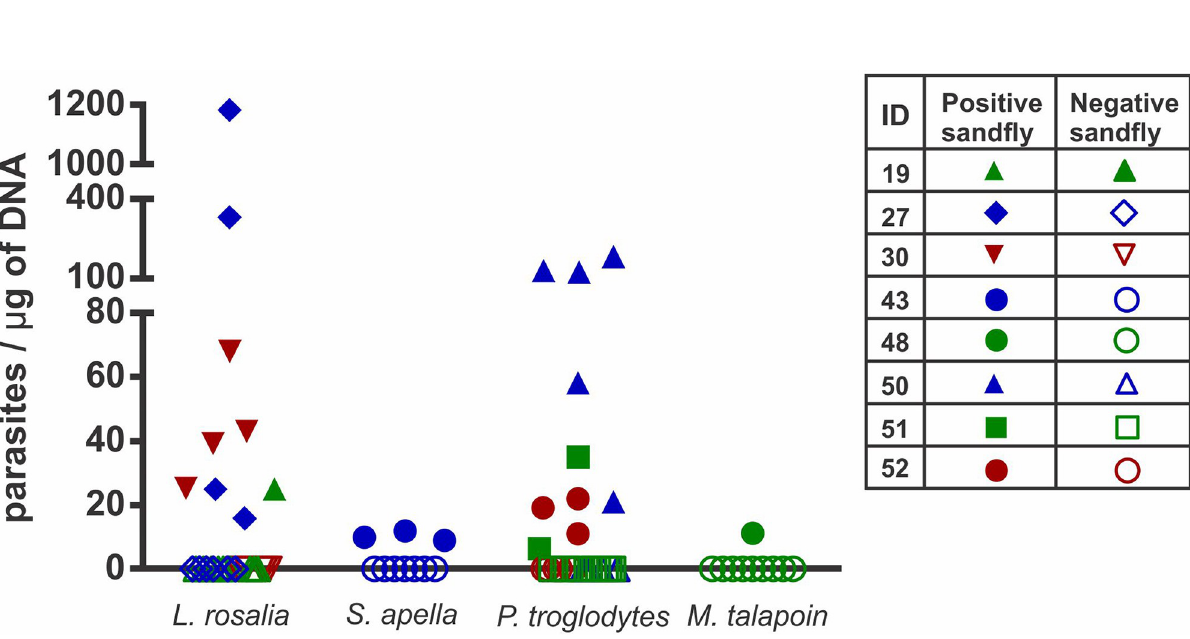
Fig 2. Quantitative analysis of Leishmania infantum in Lutzomyia longipalpis exposed to non-human primates. Relative quantification of L . infantum promastigotes in each individual positive sand fly according to the non-human primate species. Symbols refer to individual animals: open symbols indicate negative sand flies, and solid symbols indicate infected sand flies.